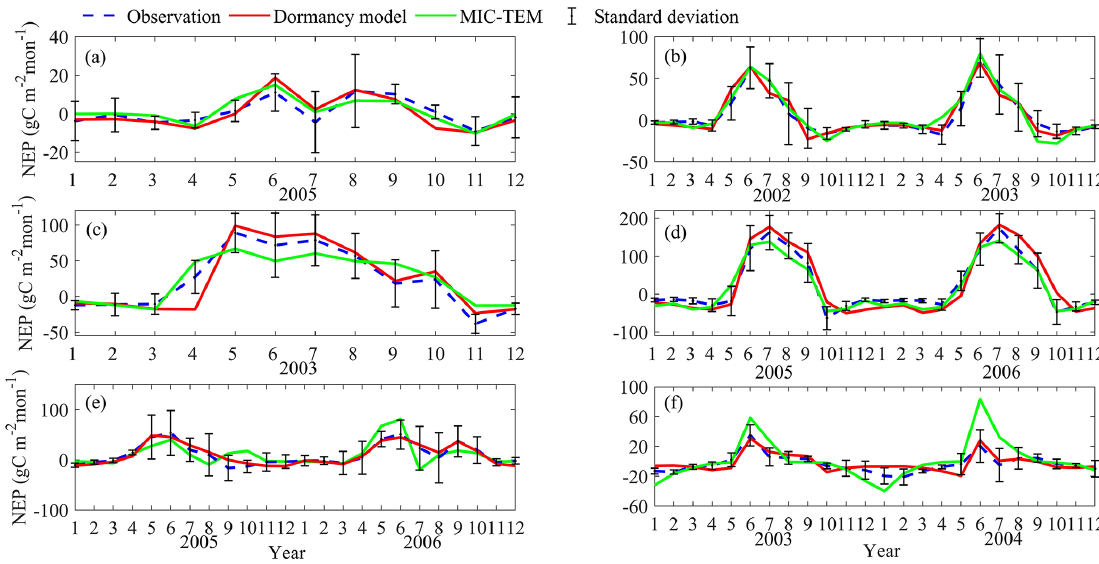
Figure 4. Comparison between observed and simulated NEP (gCm − 2 per month) at (a) Ivotuk (alpine tundra), (b) UCI-1964 burn site (boreal forest), (c) Howland Forest (main tower) (temperate coniferous forest), (d) Bartlett Experimental Forest (temperate deciduous forest), (e) Brookings (grassland), and (f) Atqasuk (wet tundra). Note: scales are different. Table 4. Site description and measured R H data used to validate the MIC-TEM-dormancy model. Site Location (latitude Elevation Vegetation Data range (degrees)/ (m) type longitude (degrees))